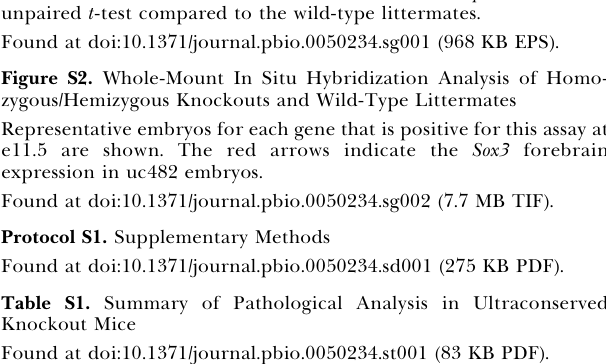
Table S1. Summary of Pathological Analysis in Ultraconserved Knockout Mice